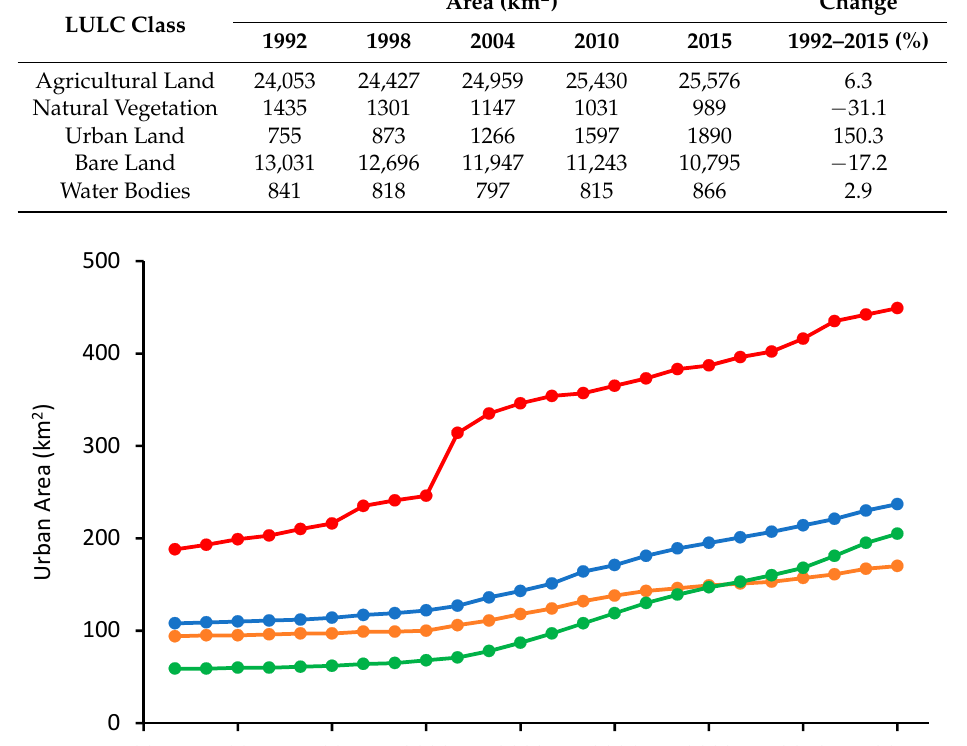
Table 2. Areas of transitions changes within LULC classes in the Nile Delta from 1992 to 2015.